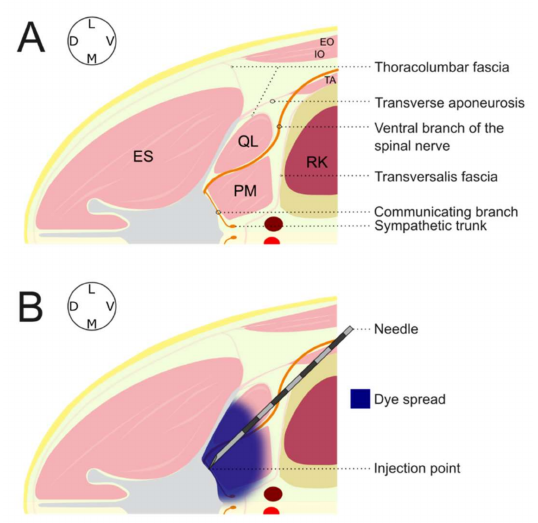
Figure 3. Schematic illustration of injection area at the L1 region in a dog placed in left lateral recumbency. ( A ) Main anatomical structures. ( B ) Final position of the needle and spreading of the injectate as observed in most hemiabdomens. L1, first lumbar vertebra; EO, external oblique muscle; IO, internal oblique muscle; TA, transverse abdominal muscle; ES, erector spinae muscles; QL, quadratus lumborum muscle; PM, psoas minor muscle; RK, right kidney; L, lateral; M, medial; D, dorsal; V, ventral.